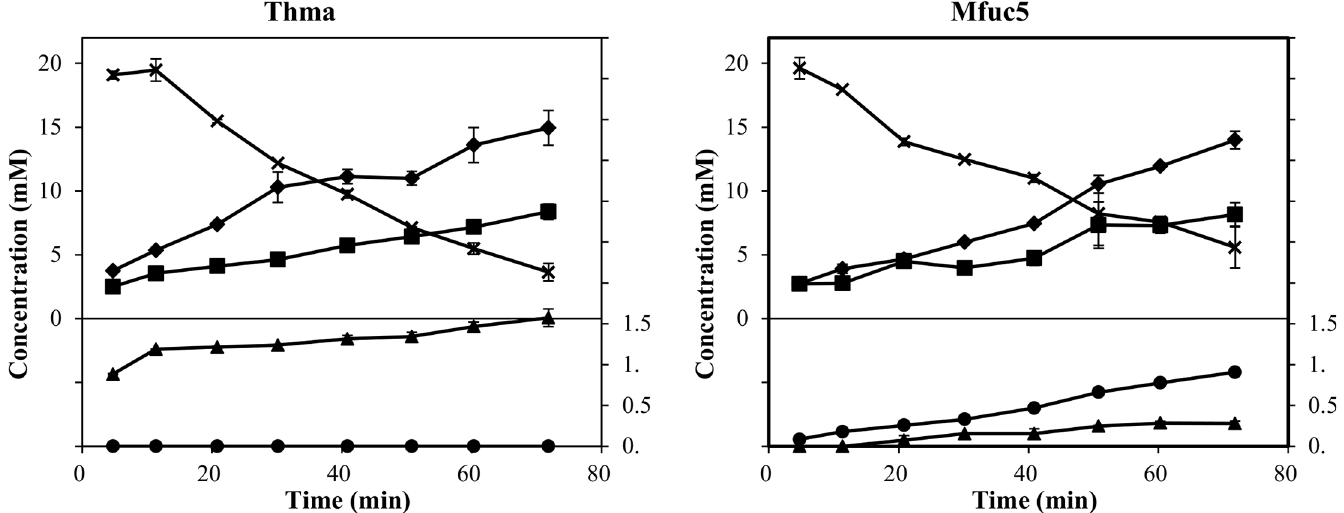
Fig 3. Time study of trans-fucosylation catalysed by Thma and Mfuc5. Reactions were done using 25 mM pNP-Fuc as donor and 100 mM lactose as acceptor at 30°C and optimal pH. The concentrations were determined by HPAEC-PAD and for pNP by spectrophotometry. L-fucose ( ■ ), pNP ( ♦ ), pNP-Fuc (X), 2 ’ -FL ( ▲ ), and 3-FL ( ● ).